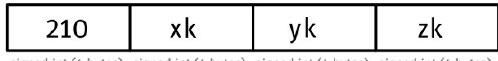
Figure 5. Basic LeicaConector proxy frame.